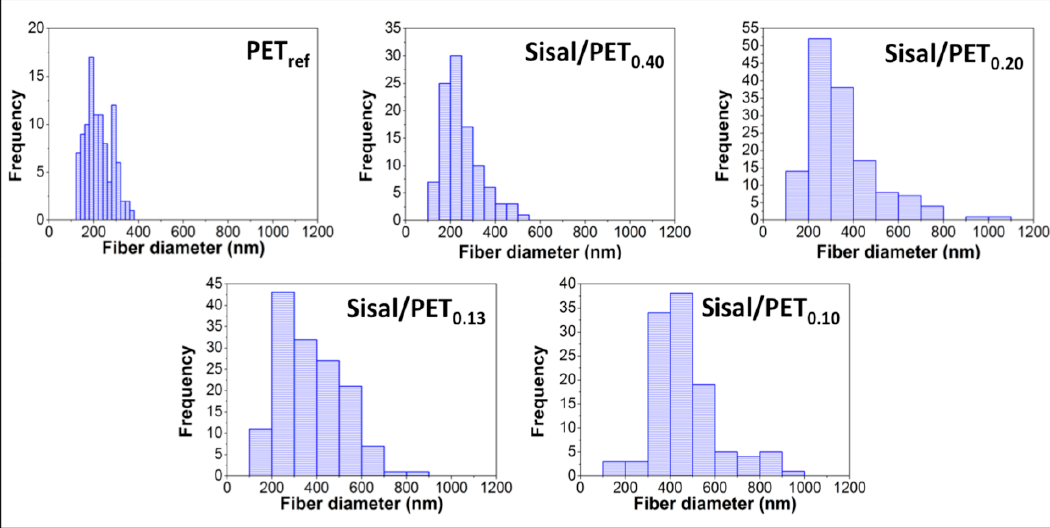
Figure 4. Histograms of fiber diameter frequency for the electrospun mats.